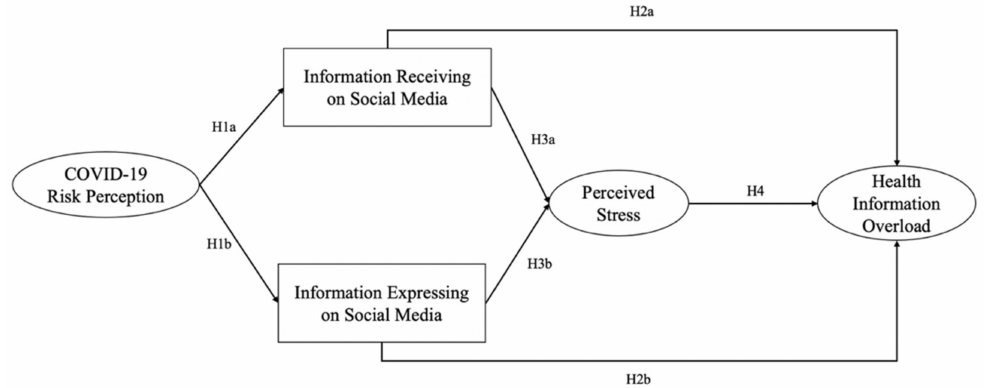
Figure 1. Conceptual